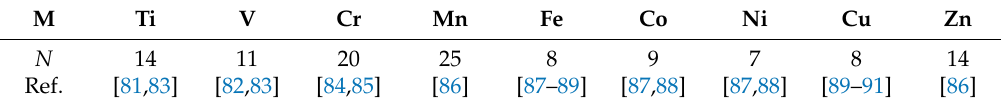
Table 3. Total number of Al 2 M 3 ( N ) metal cluster isomers for various M of 3 d -elements. M Ti V Cr Mn Fe Co Ni Cu Zn